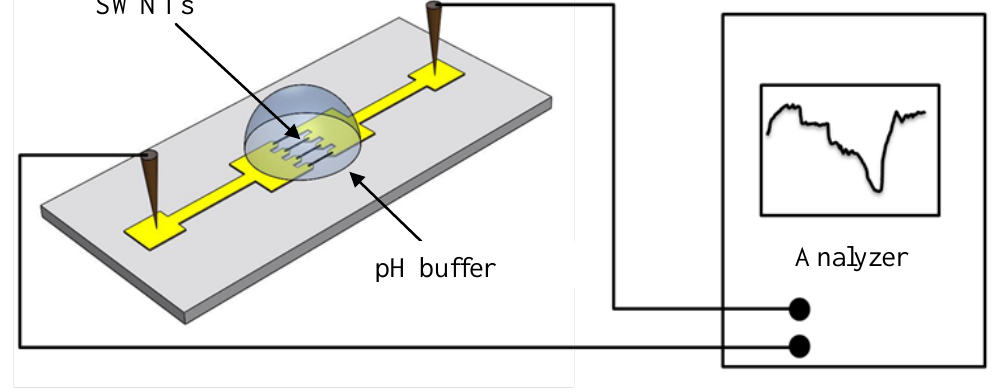
Figure 3. Schematic diagram of the pH sensing